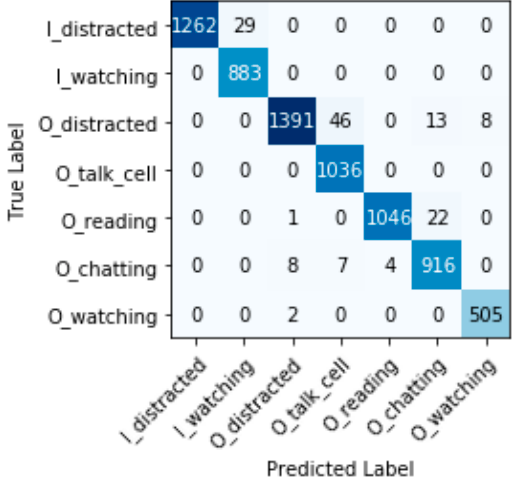
Figure 13. Confusion matrix ResNet-50.